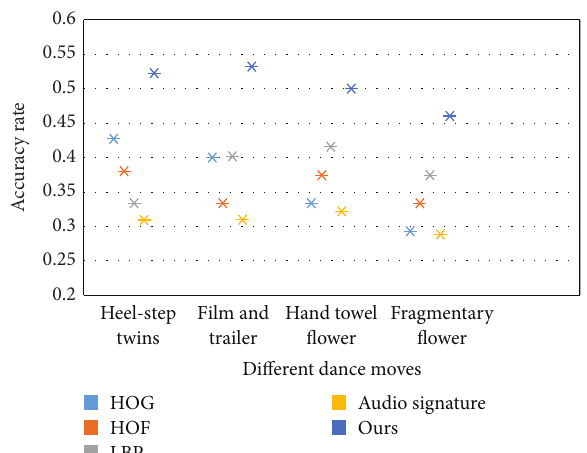
Figure 5: Comparison of experimental results between the algorithm in this paper and other algorithms on different dance combinations.